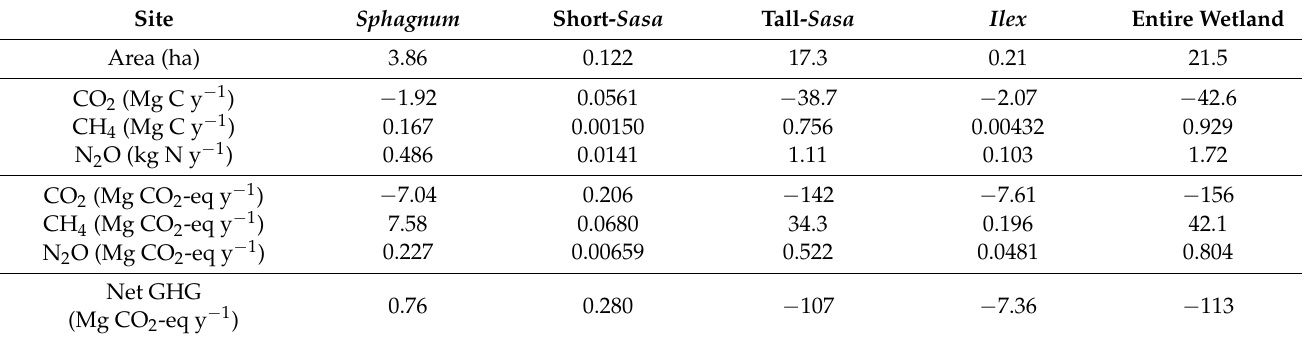
Table 3. GHG budget from the Bibai Wetland estimated by spatial distributions of environmental factors.